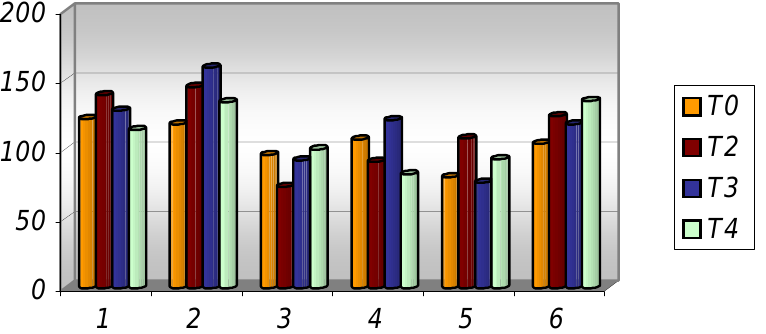
Figure 2: Variation of cardiac frequency values among the six animals of G1 (0.25 mg/kg) at the four moments studied (T0 = pre-envenomation; T2 = 6h after envenomation; T3 = 24h after envenomation; and T4 = 72h after envenomation). Botucatu, São Paulo, Brazil, 2003.